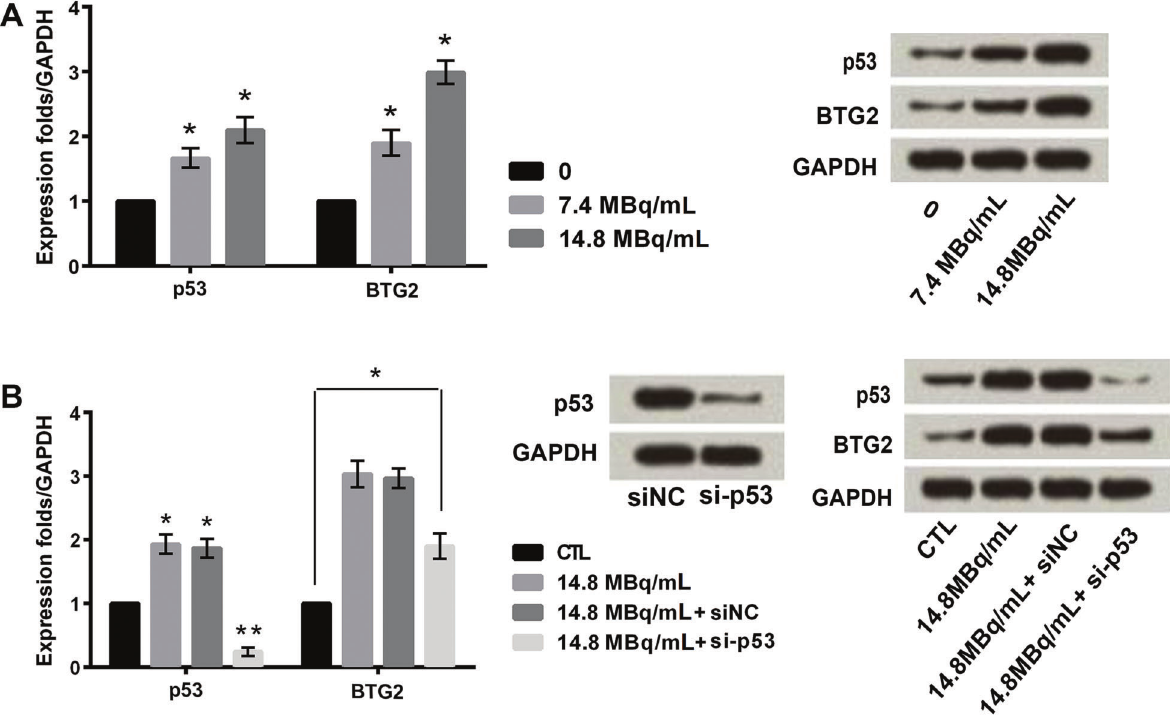
Figure 2. Effects of different concentrations of iodine-131 ( 131 I) on expression of p53 and BTG2 ( A ). B , Expression of BTG2 was raised even with silencing of p53 (si-p53). Data are reported as means ± SD. *P o 0.05. **P o 0.01 compared with control (CTL – GAPDH)